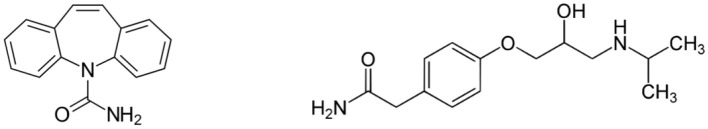
Molecular structure of carbamazepine (left side) and atenolol (right side).